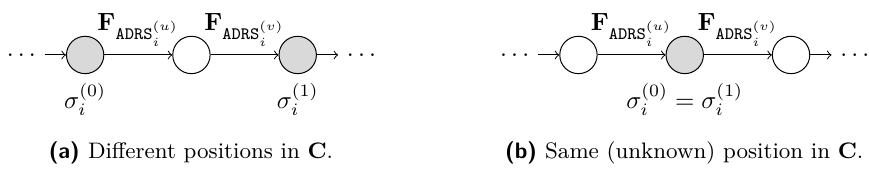
Figure 5: Identifying W-OTS + values within non-verifiable